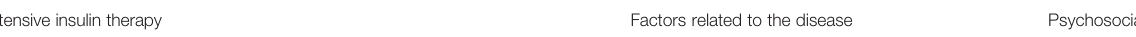
TABLE 2 | Causes of obesity in children with type 1 diabetes. Intensive insulin therapy Factors related to the disease Psychosocial